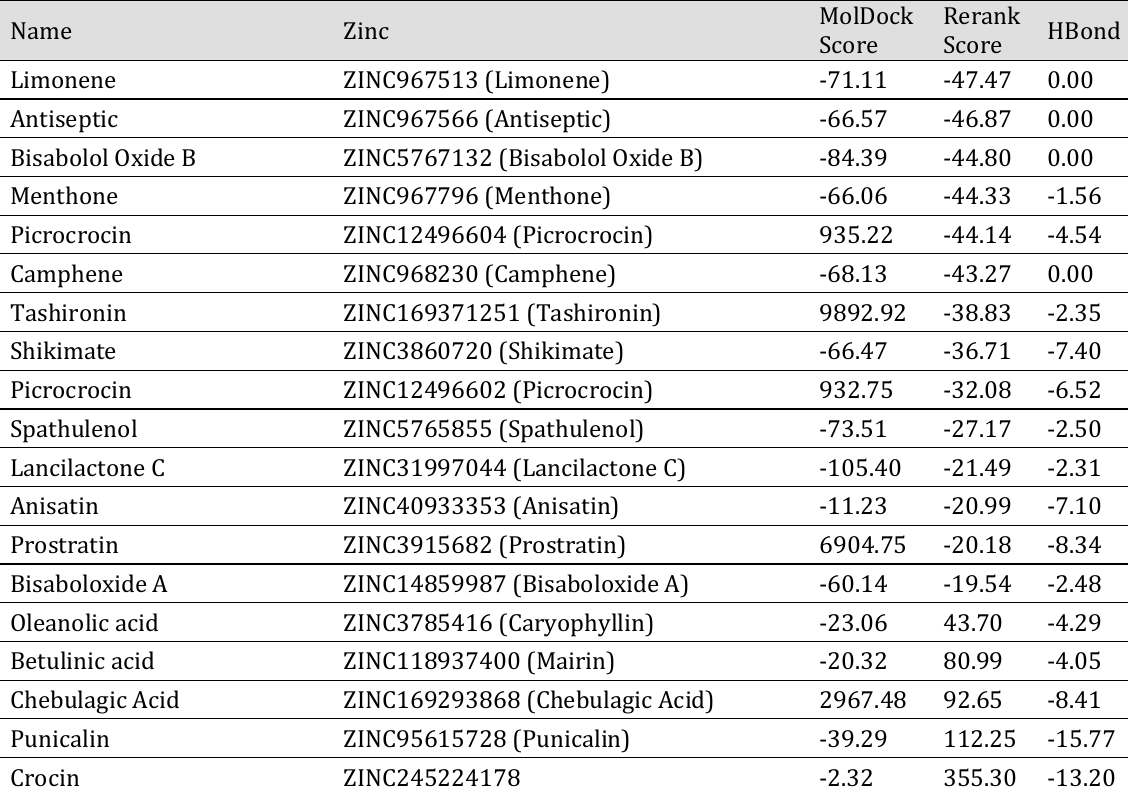
Table 5. The predicted poses scores of the rest inspected antiviral plant based compounds